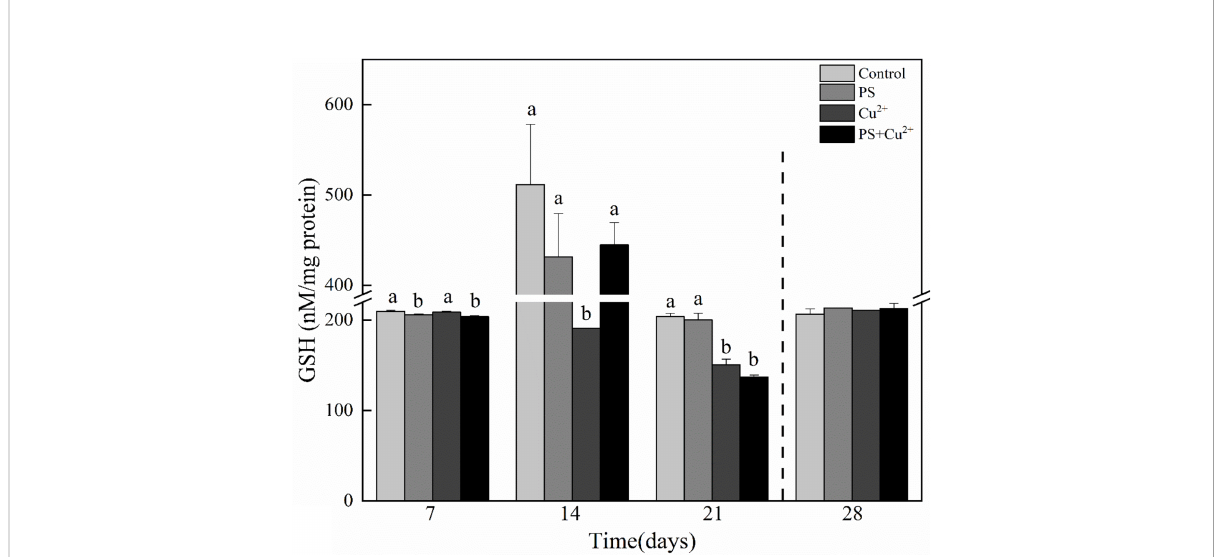
FIGURE 4 Glutathione (GSH) activities in whole tissues of Tachypleus tridentatus exposed to 100-nm micro-PS (10 4 particles l -1 ), Cu 2+ (10 µg l -1 ), and a combination of PS and Cu 2+ at days 7, 14, and 21, allowed to recover for 7 days (28 days). Data are given as mean values ± standard deviations. The superscripts of different lowercase letters indicate signi fi cant differences (p < 0.05) between the four